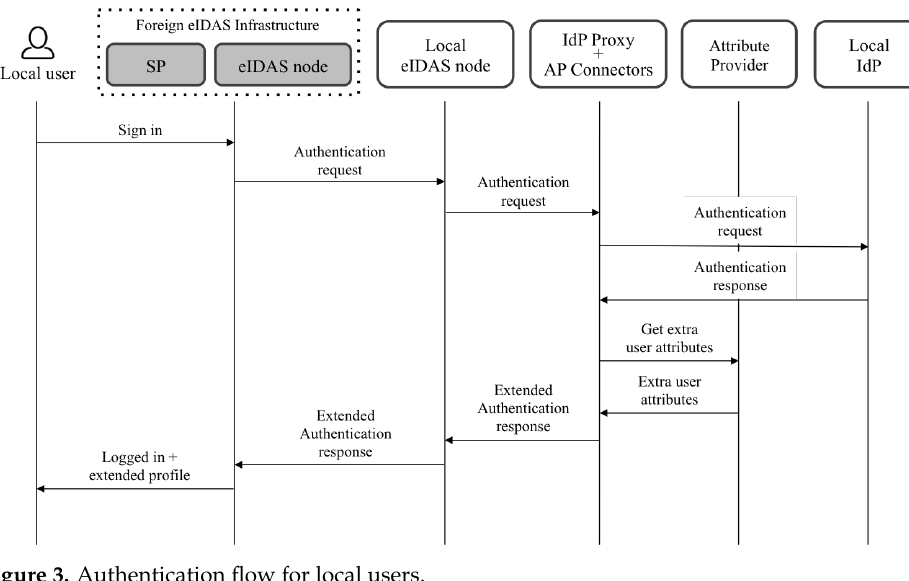
Figure 3. Authentication flow for local users.